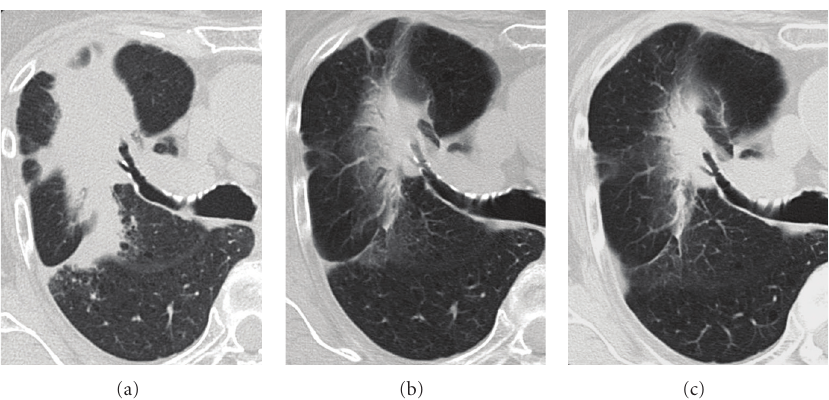
Figure 5: Serial CT images. (a) CT images at 15 months after SBRT show the mass-like consolidation enlarged at its dorsal side. (b), (c) CT images at 18 and 27 months after SBRT show that the mass-like consolidation gradually retracted.